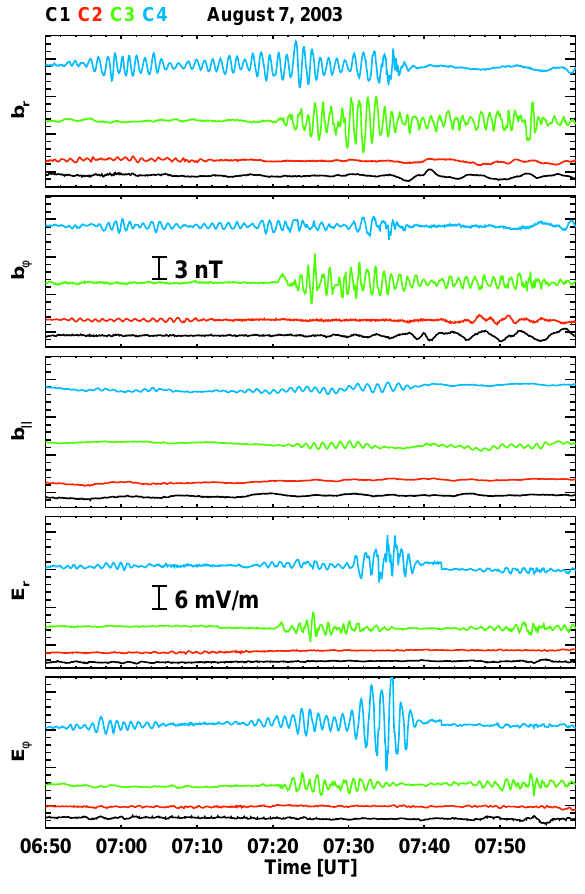
Fig. 4. Components of the Poynting vector S observed by space- craft C3 and C4. The thick line represents the time-average energy